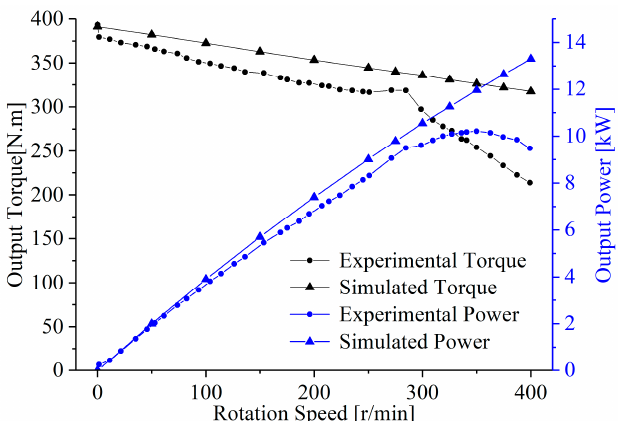
Figure 6. Comparison of turbodrill output performance under simulated and experimental condi- tions.